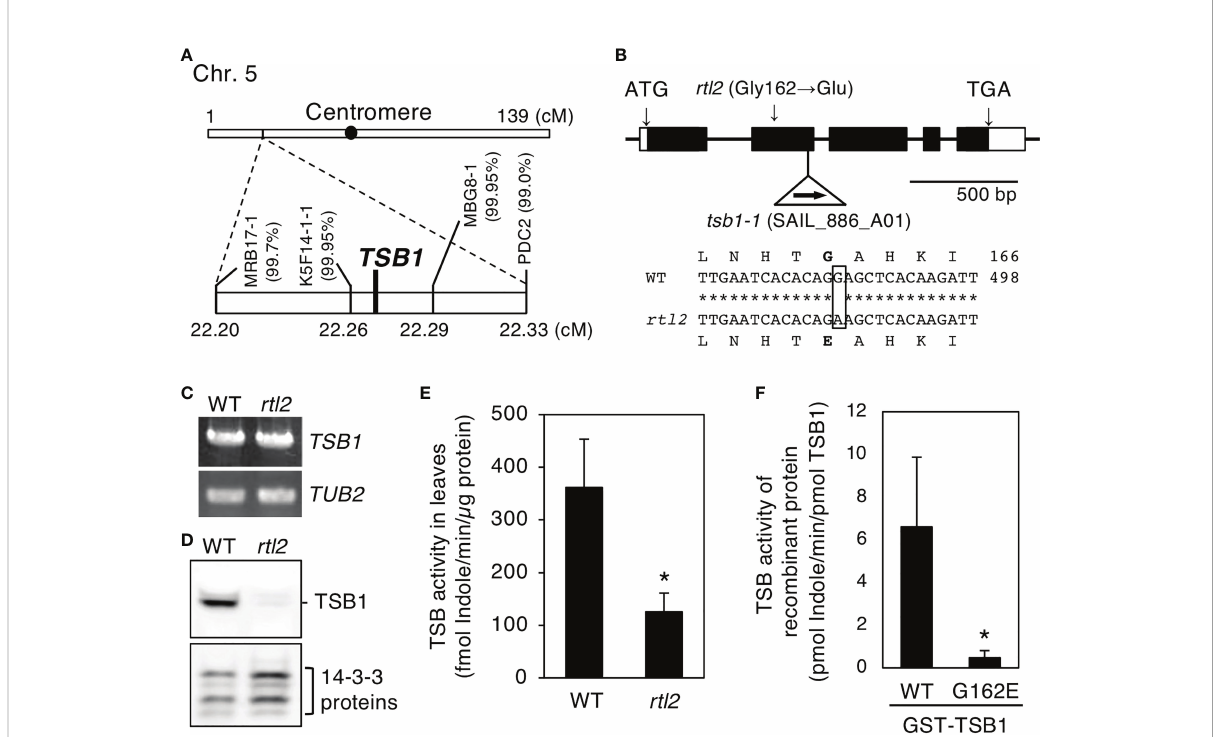
FIGURE 2 Determination of the mutation in the rtl2 mutant. (A) Mapping analysis of the RTL2 locus. Numbers in parentheses indicate percentages of no recombination in 1820 chromosomes. The RTL2 locus was close to CAPS marker K5F14-1-1, MBG8-1 and Tryptophan synthase ß subunit 1 ( TSB1 ). (B) Schematic representation of the structure of the TSB1 gene and the position of T-DNA insertion in the tsb1-1 mutant (upper). Boxes and lines represent exons and introns respectively. The T-DNA insertion was located in 2nd exon of the TSB1 gene. The position of the amino acid substitution (Gly162 to Glu) in rtl2 is indicated. The partial sequences of TSB1 cDNA and the deduced amino acid in WT and rtl2 are shown (lower). A single nucleotide substitution (G485 to A) is shown by a box. Nucleotide and amino acid numbers are indicated in the right. Asterisks indicate the same nucleotide of the TSB1 gene in WT and rtl2 . (C) TSB1 expression analyzed by RT-PCR in WT and rtl2 . Total RNA was extracted from rosette leaves of 5-week-old plants grown on MS plate for 4 weeks and transferred to soil for 1 week. TUB2 was ampli fi ed as a control. PCRs were performed with 30 cycles for TSB1 and with 25 cycles for TUB2 , respectively. (D) Immunoblot analysis of TSB1 protein in WT and rtl2 . Twenty micrograms of protein extracted from rosette leaves of 5-week-old plants was loaded on each lane. The 14-3-3 proteins were detected using anti-14-3-3 antibody as a control. (E) TSB activity in rosette leaves of 5-week-old WT and rtl2 . Values are means of three independent experiments with SDs. Asterisk indicates a signi fi cant difference in TSB activity relative to WT by Student t test (* P < 0.05). (F) TSB activity of recombinant TSB1 (WT) and TSB1-G162E. Values are means of three independent experiments with SDs. Asterisk indicates a signi fi cant difference in TSB activity relative to WT by Student t test (* P <